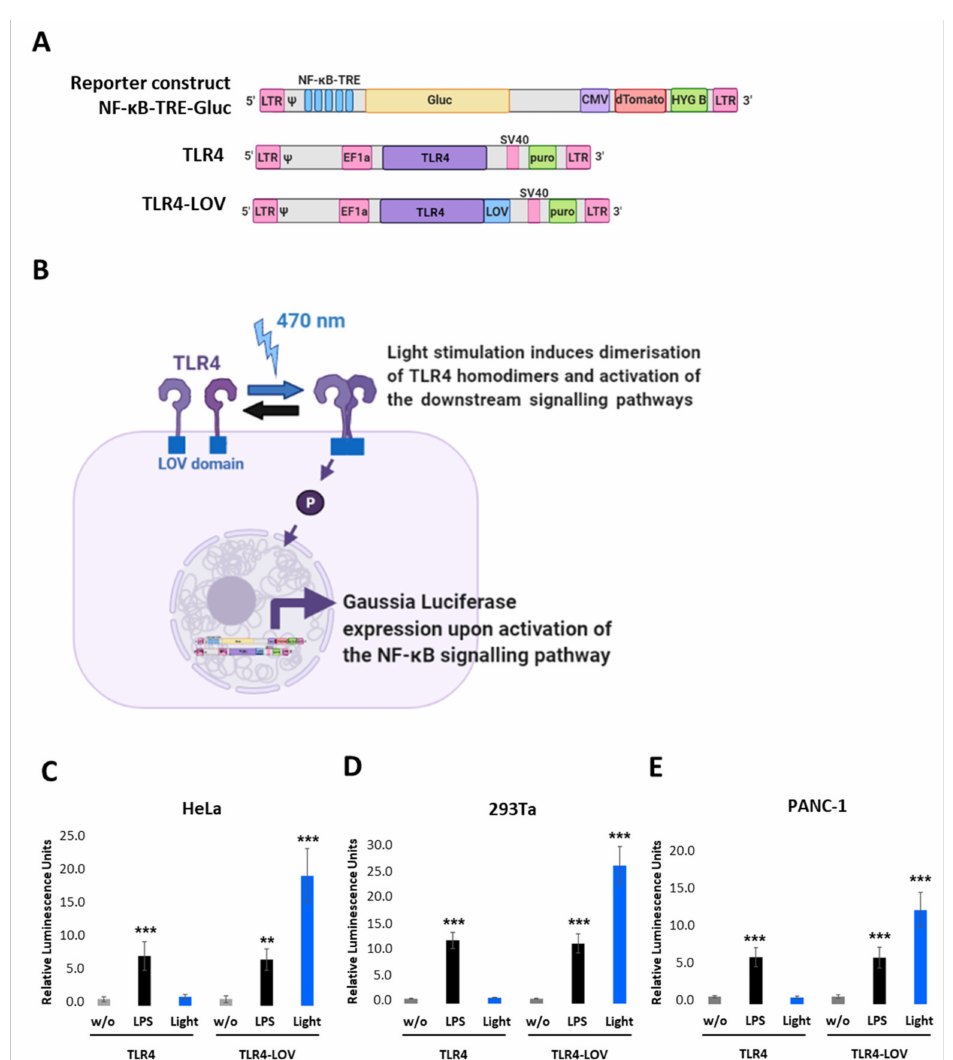
Figure 1. Design and functional analysis of the NF- κ B-TRE-Gluc reporter and TLR4-LOV construct. ( A ) Schematic representation of the engineered NF- κ B-TRE-Gluc reporter, the TLR4, and the TLR4-LOV constructs. NF- κ B-TRE-Gluc encompasses five tandem repeats (TRE), Gaussia Luciferase (Gluc), dTomato under the control of CMV promoter, and Hygromycin B (HYG B). TLR4-LOV consists of a full-length human TLR4 molecule with an incorporated LOV domain at the C-terminal intracellular domain. ( B ) Schematic representation of the function of TLR4-LOV. Homodimerisation and activation of NF- κ B in response to blue light can be detected in real-time via measuring Gluc. ( C ) HeLa, ( D ) 293Ta, and ( E ) PANC-1 were transiently co-transfected with either TLR4 or TLR4-LOV with the NF- κ B-TRE-Gluc reporter, and Gluc was measured 6 h post LPS (100 ng/mL) or light (470 nm, 7 V, 7.5 min) treatment, respectively, or left untreated (w/o). Post- ANOVA multiple comparisons relative to the control were performed using Dunnett’s test. Error bar = SD. n = 6; ** p < 0.01, *** p <